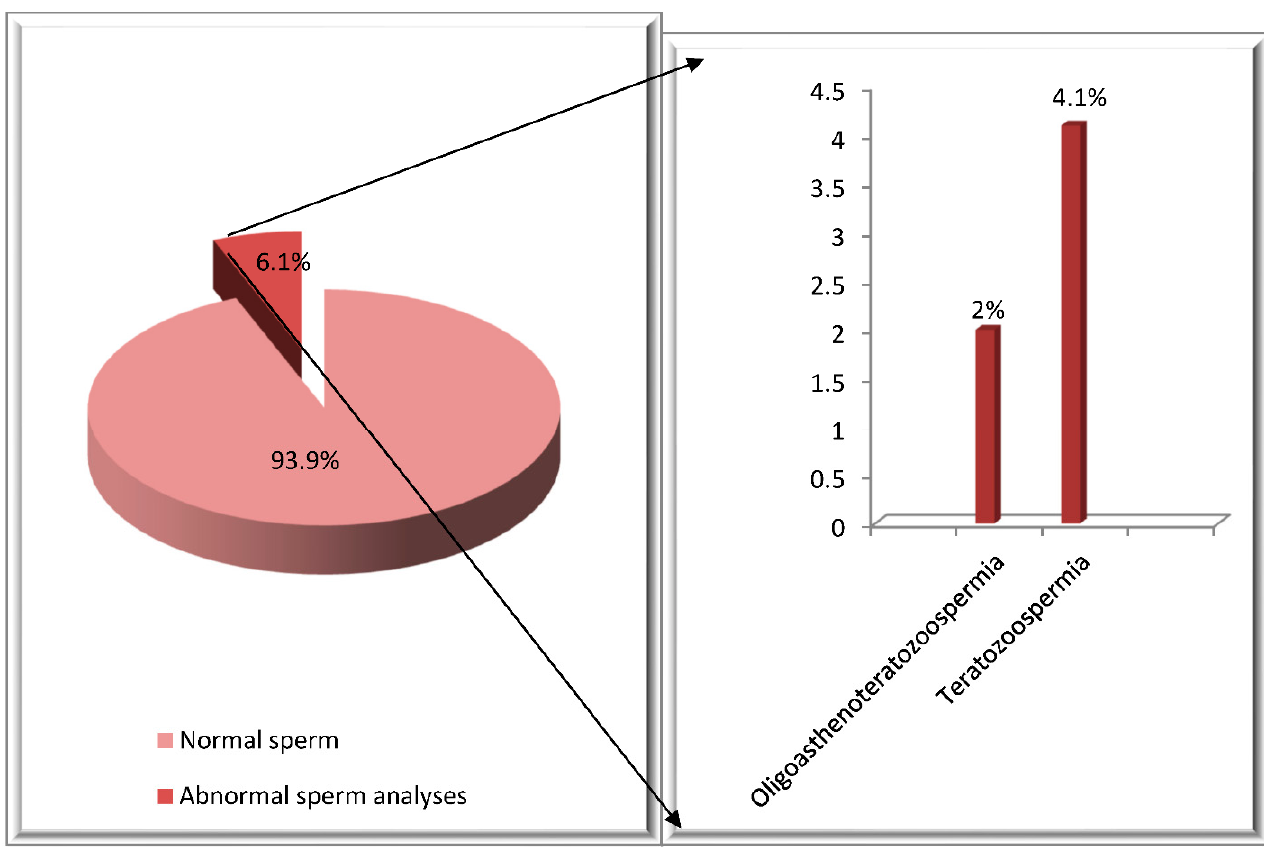
Figure 2. Distribution of HD patients according to spermogram findings following ABVD treat- ment.